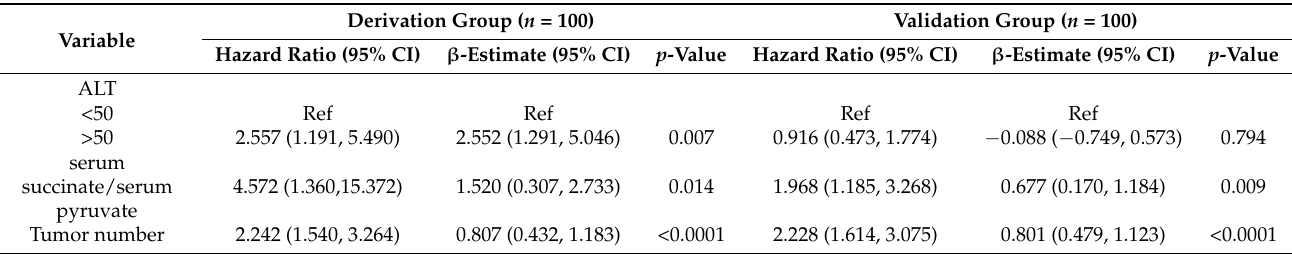
Table 1. Multivariable Cox regression analyses of the prognostic factors in the derivation and validation groups of the Chinese cohort with metabolic